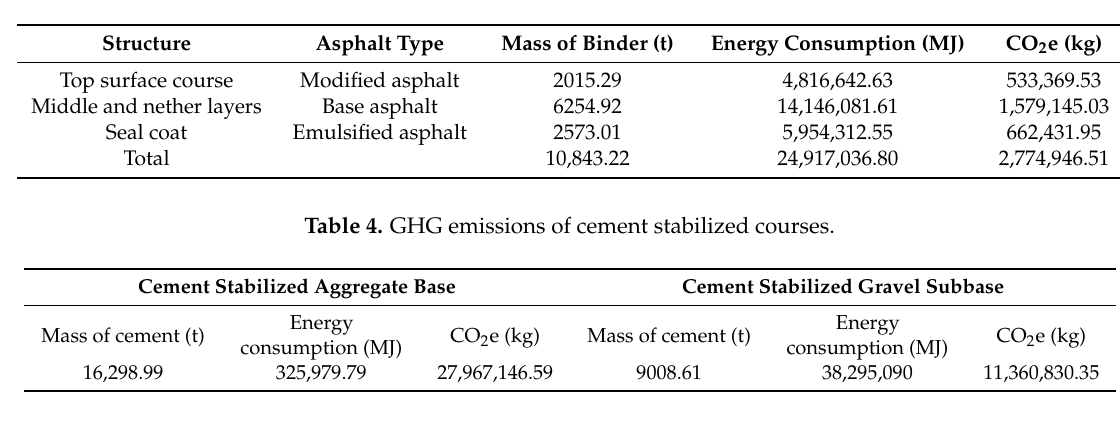
Table 3. GHG emissions of asphalt courses.